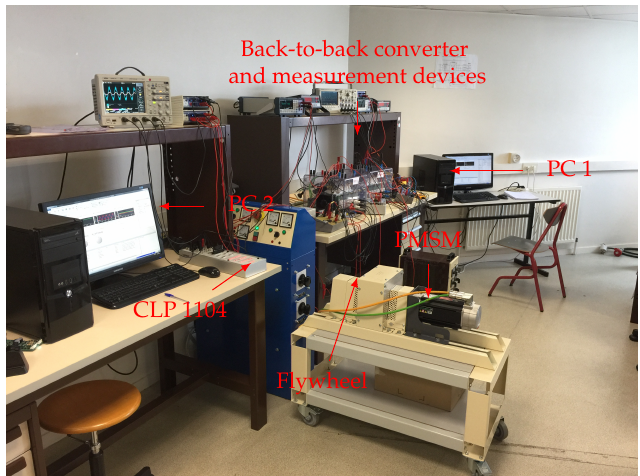
Figure 10. Laboratory prototype.